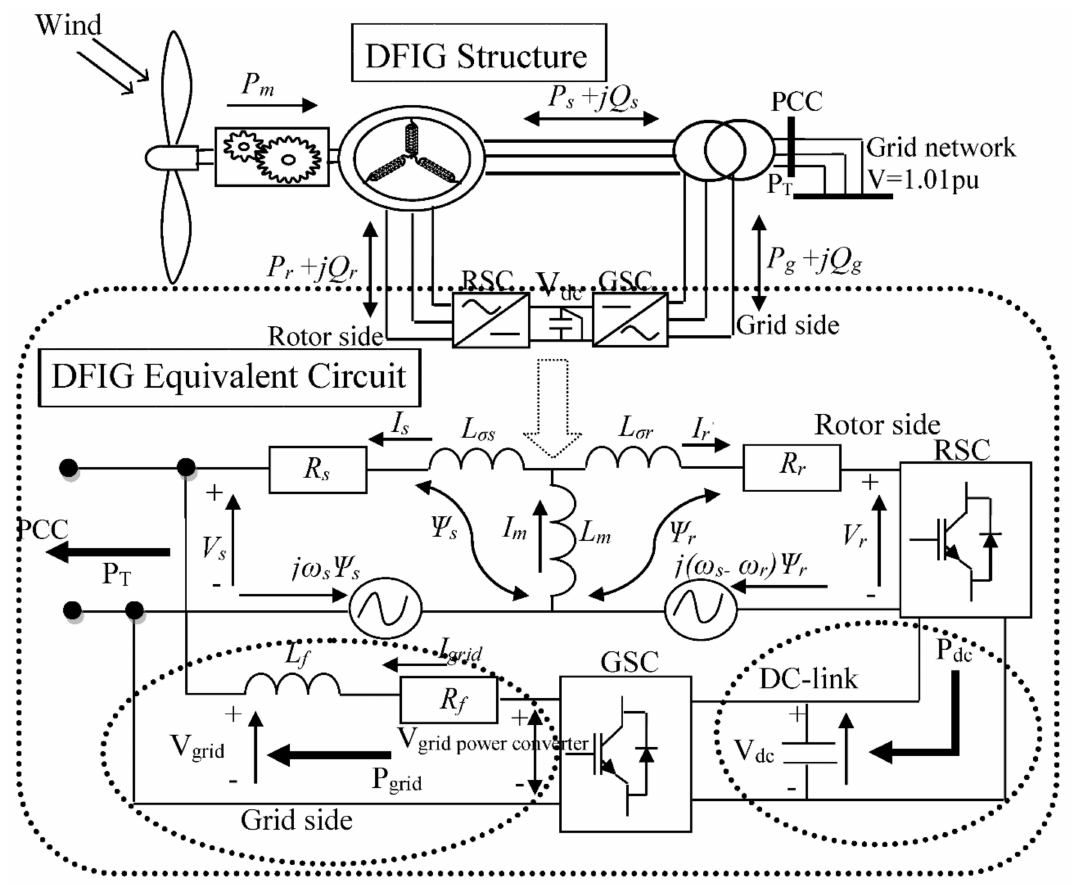
Figure 2. DFIG grid-connected equivalent circuit.